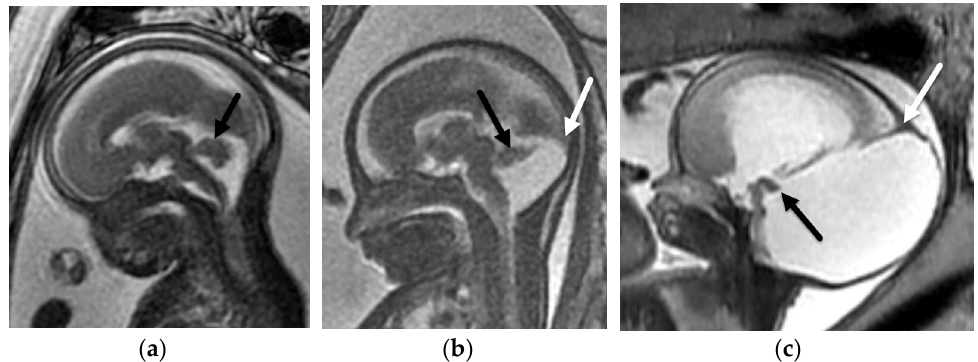
Figure 8. Dandy–Walker Continuum. Sagittal BTFE/FIESTA image from fetal MRI at 25 weeks and 3 days GA with isolated Blake pouch remnant. ( a ) The vermis (arrow) is normal in size and morphology; however, it is mildly rotated. Sagittal BTFE/FIESTA image from fetal MRI at 27 weeks GA with vermian hypoplasia with co-existing Blake pouch remnant ( b ) demonstrates a hypoplastic and rotated vermis (black arrow); however, the torcular (white arrow) is not elevated. Sagittal T2-SSFSE image from fetal MRI of classic Dandy–Walker malformation ( c ) at 26 weeks and 6 days GA with non-visualization of the vermis posterior to the tectum (black arrow) and a markedly elevated torcular (white arrow) with enlargement of the posterior cranial fossa and obstructive hydrocephalus.